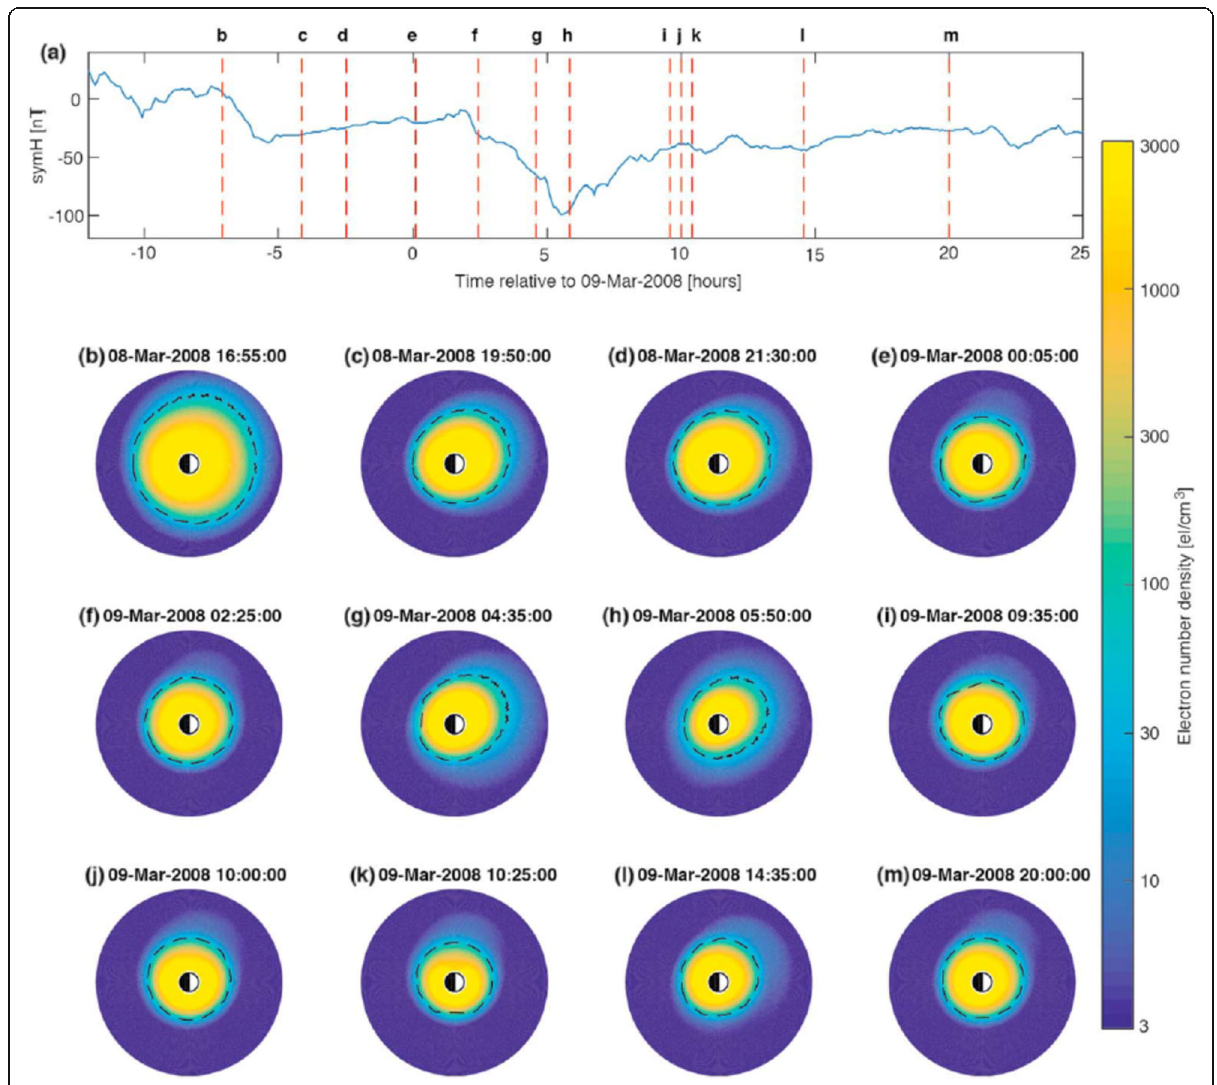
Fig. 13 Neural network reconstruction of the global plasma density as a function of L and MLT. a The SYM-H index relative to 9 March 2008 00:00 UT. The red vertical dashed lines correspond to the times of the snapshots shown in the 12 panels beneath. The common color scale indicating electron density in electrons per cubic centimeter is shown on the right, and the dashed line in b – m represents the 50 el/cm 3 contour. The entire simulation period is outside the training interval (i.e., out of sample) (taken from Bortnik et al.